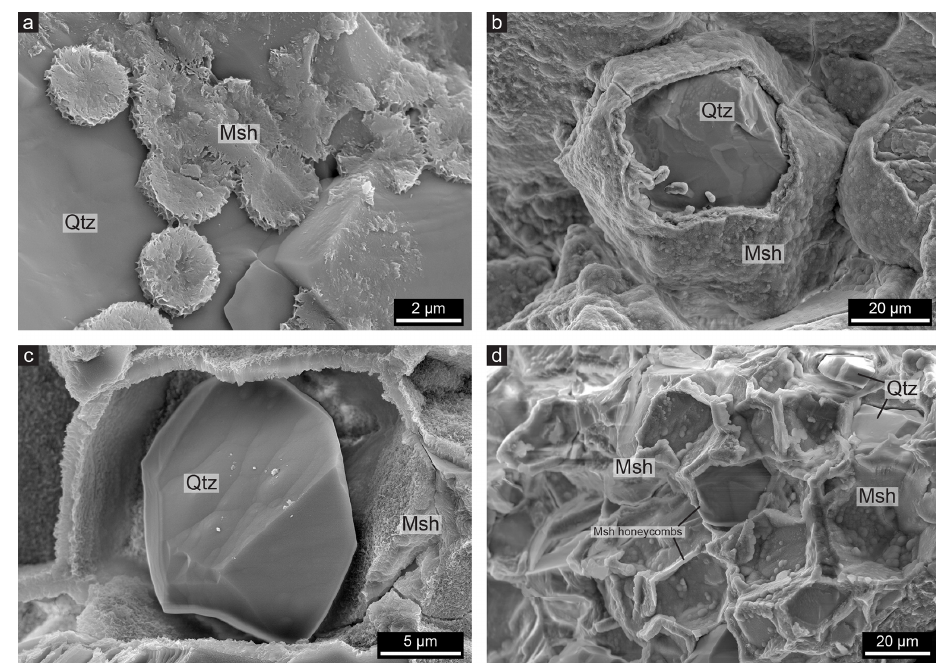
Figure 4. SE images of non-polished whole rock samples showing quartz (Qtz) with a magnesium silicate hydrate (Msh) coating. (a) At initial stages of cement precipitation, it forms in disc shapes on the quartz surfaces. As the cement forms on the quartz surface, it takes over the topography of the grains, giving the cement a smooth outer surface but a flaky inner texture. (b) A hexagonal quartz grain almost completely covered with cement. (c) A quartz grain that started to dissolve after the cement was precipitated, leading to a void between the quartz and the cement layer. (d) Quartz grains that are completely dissolved; a network of mostly empty pore spaces in the shape of honeycombs is